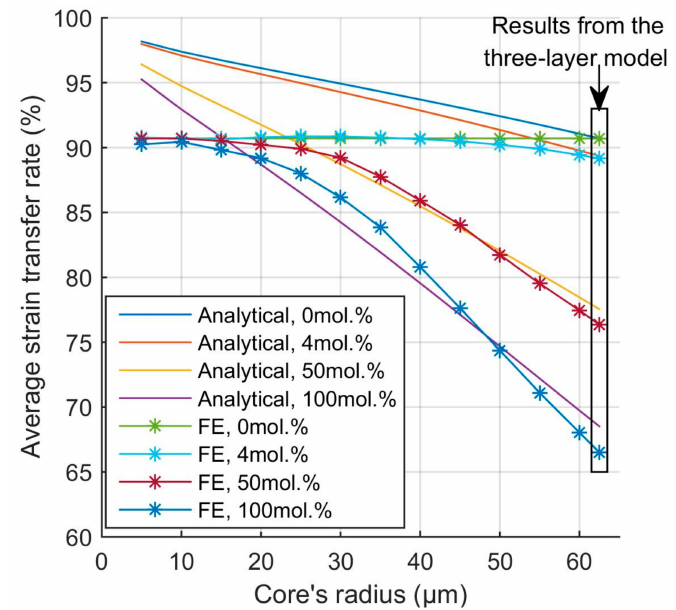
Figure 6. Influence of core radius and alumina content on average strain-transfer rate (ASTR) calculated from four-layer model and finite-element (FE) model.